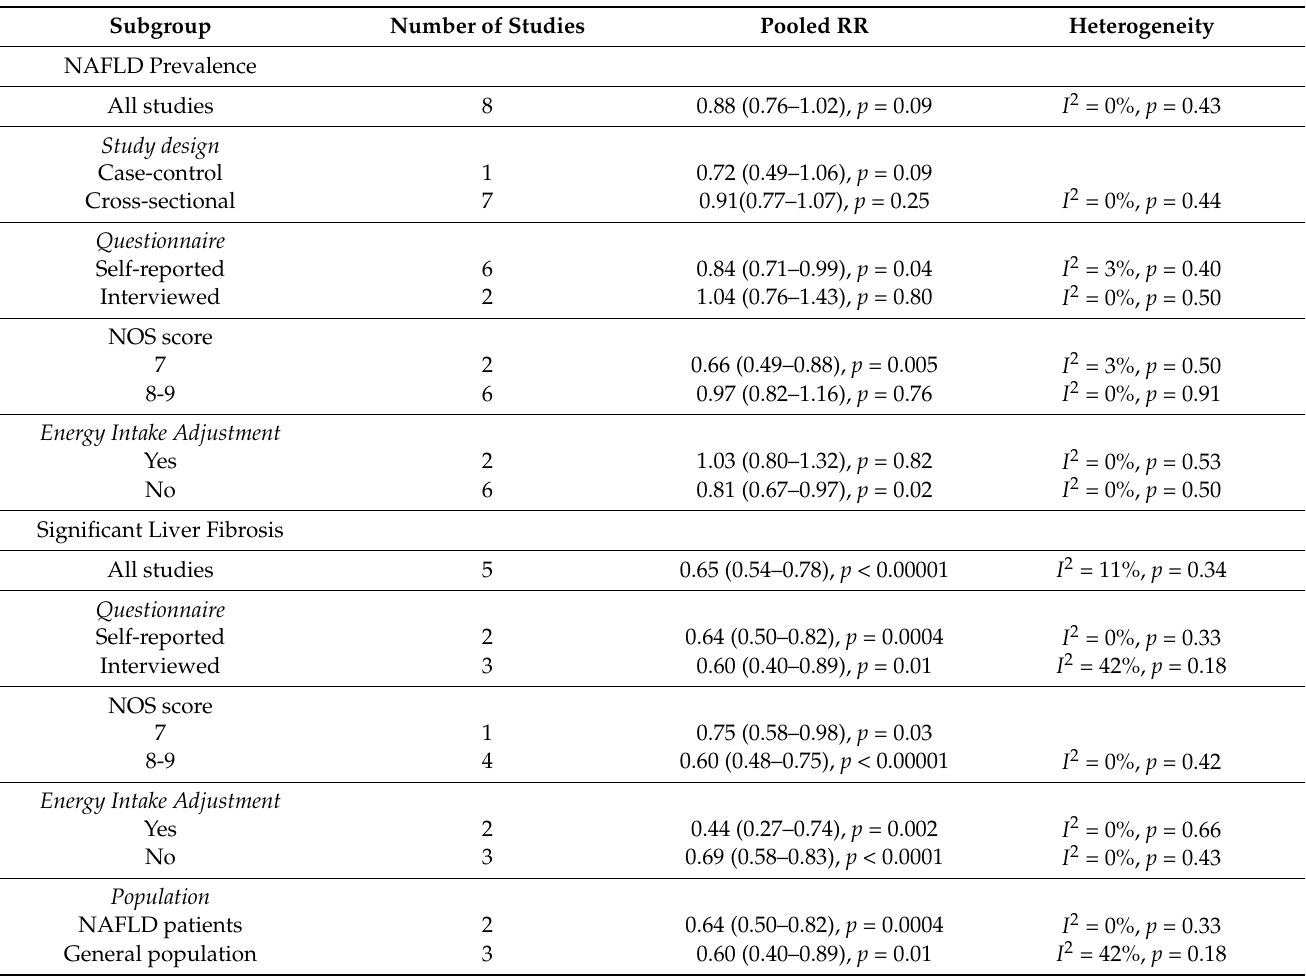
Table 2. Subgroup meta-analysis of coffee consumption and (a) NAFLD prevalence, (b) significant liver fibrosis stratified by study design, questionnaire administration, study quality, and energy intake